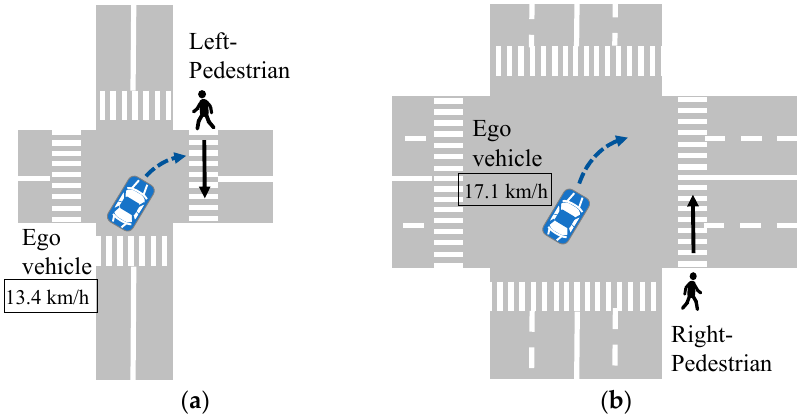
Figure 10. Size of the intersection with vehicles traveling on the left side of roads where near-miss incidents are frequently observed: ( a ) Left-Pedestrian; ( b ) Right-Pedestrian .